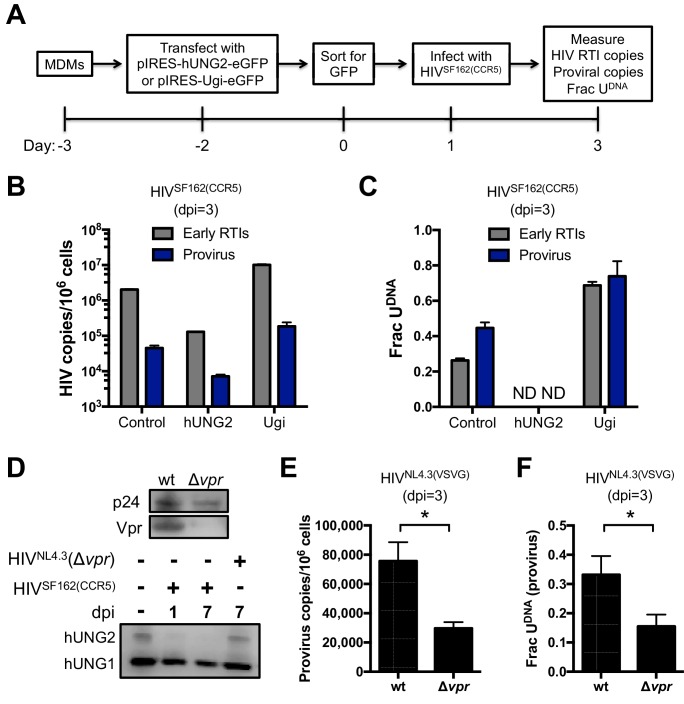
hUNG2 uracil excision activity are required for efficient pre-integration restriction.Effect of transient overexpression of nuclear hUNG2 and Ugi on copies of viral early reverse transcription intermediates (RTIs) and proviruses. (A) Experimental scheme for hUNG2 and Ugi overexpression in MDMs. (B) Copies were determined by qPCR using specific primers for early RTIs and provirus. (C) Fraction of viral RTIs and provirus that contained detectable uracil under conditions of hUNG2 depletion (Ugi) and overexpression (hUNG2). ND; Not detectable. (D) Western blot analysis of the vpr deletion virus HIVNL4.3(Δvpr) revealed no detectable Vpr. Western blot analysis to detect nuclear (hUNG2) and mitochondrial (hUNG1) hUNG isoforms detected oscillation in the hUNG2 levels over the course of a 7-day multi-round infection. At day 7, the HIVNL4.3(Δvpr) shows abundant hUNG levels while hUNG2 is depleted in the wild-type infection. (E) Measurements of provirus copy number in a mixed population of GFP− and GFP+ MDMs infected with HIVNL4.3(VSVG) (wt) and HIVNL4.3(Δvpr). (F) Ex-ALU-gag nested qPCR measurements of the fraction of uracilated proviral copies in a mixed population of GFP− and GFP+ MDMs infected with HIVNL4.3(VSVG) (wt) and HIVNL4.3(Δvpr) at 3 days post-infection. Level of statistical significance (*p<0.05). Number of experimental replicates (n = 4–5) and errors are reported as mean ± SD.DOI:
http://dx.doi.org/10.7554/eLife.18447.01510.7554/eLife.18447.016Figure 4—source data 1.Ex-ALU-gag qPCR for measurement of reverse transcription intermediates (RTIs), provirus and uracil content in MDMs transfected with plasmids encoding hUNG2, Ugi or empty control (Figure 4B,C).Provirus and uracil content in MDMs infected with wild-type (wt) or mutant vpr (Δvpr) virus (Figure 3E,F).